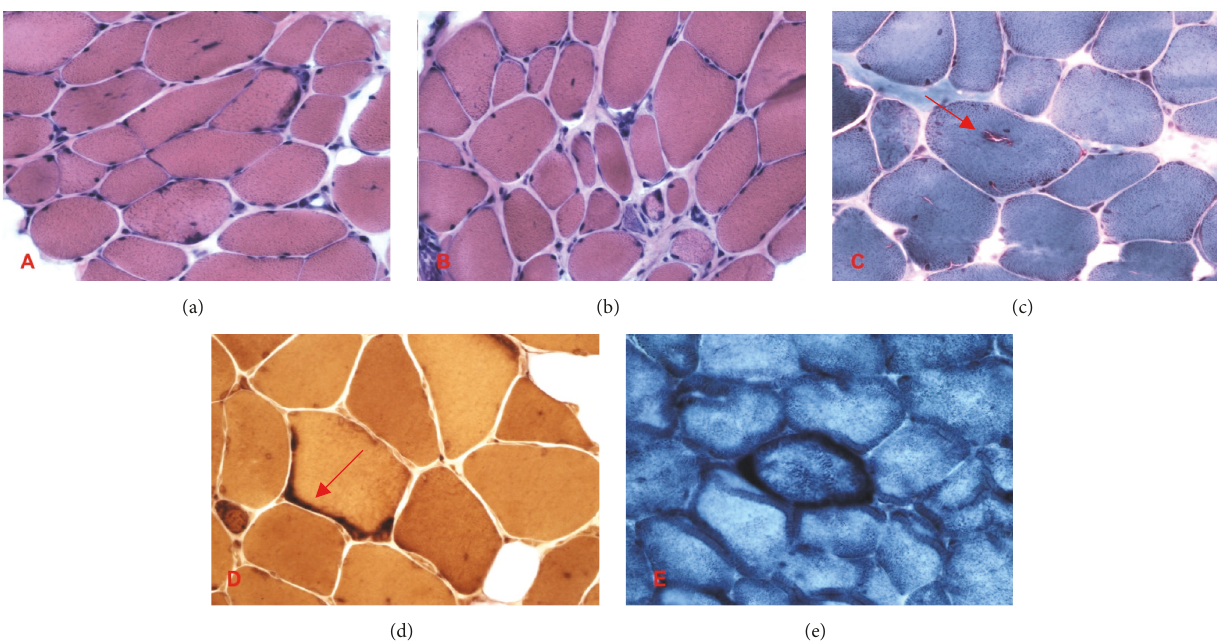
Figure 1: (a) Frozen section, H&E stain, showed mild fiber size variation and increased central nuclei. (b) Frozen section, H&E stain, demonstrated chronic fibrosis, fiber size variation, occasional central nuclei, and scattered degenerating and regenerating fibers. (c) Frozen section, Gomori trichrome stain, revealed occasional rimmed vacuoles (arrow). (d) Frozen section, nonspecific esterase (NSE) stain, also revealed occasional tubular aggregates (arrow). (e) Frozen section, NADH-tetrazolium reductase (NADH-TR) stain, revealed occasional tubular